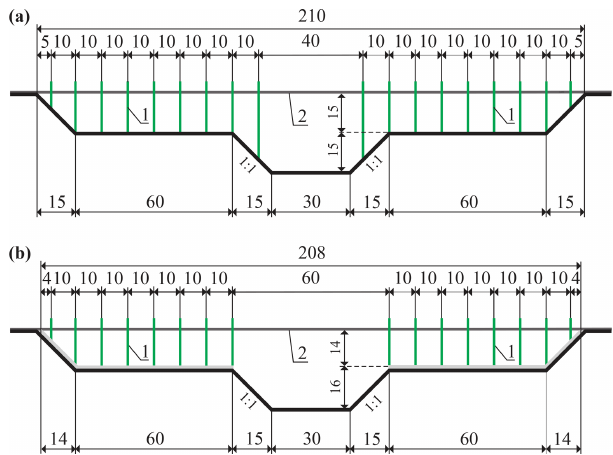
Figure 3. Laboratory channel cross section (dimensions in centime- ters); 1 – rigid cylinders simulating vegetation; 2 – wooden strips supporting vegetation (Koziol, 2010); (a) case 1; (b) case